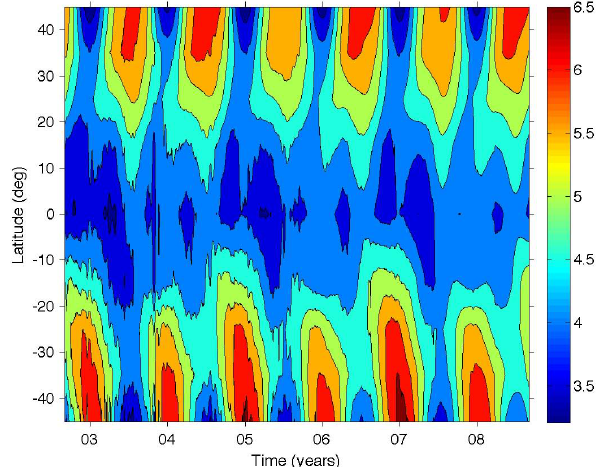
Fig. 21. NO 2 fitting components as a function of altitude in three latitude belts in the stratosphere. All amplitudes have been given as a ratio between the original amplitude in Eq. (2) and the the con- stant term c(z) in Eq. (2) and given in %. Line identifications: An- nual ( a 1 and b 1 ): solid and dashed red, respectively, Semi-annual ( a 2 and b 2 ): solid and dashed blue, respectively, QBO 10hPa ( q 1 ) and 30hPa ( q 2 ): solid and dashed green, respectively, solar ( s ): solid magenta. The zero value line has been shown by a thin black line. Left: 50 ◦ S–40 ◦ S, Middle: 10 ◦ S–10 ◦ N, Right: 40 ◦ N–50 ◦ N. Note that the x-axis ranges vary in panels.